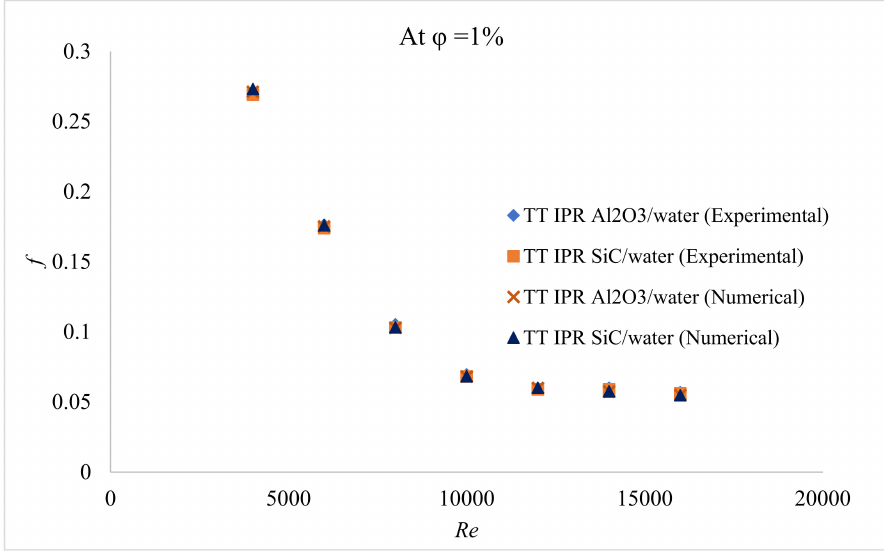
Figure 23. E ff ects of the type of nanoparticles on Nu and f.